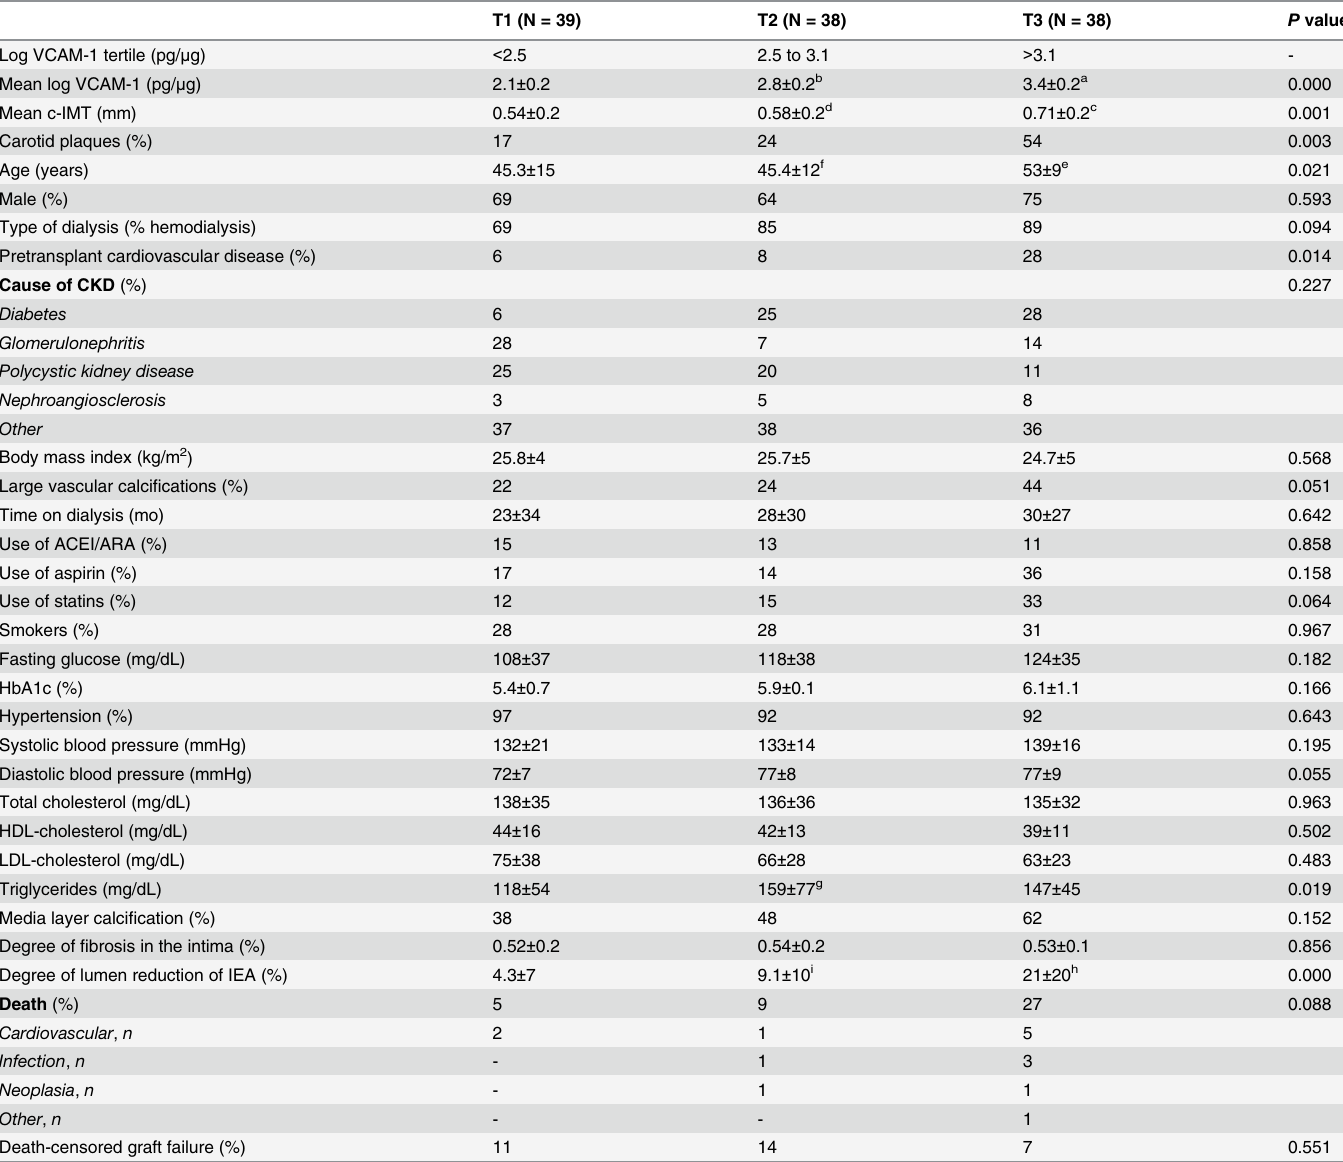
Table 2. Baseline clinical and pathological data of the artery wall in kidney transplant candidates according to VCAM-1 protein level tertiles. T1 (N =